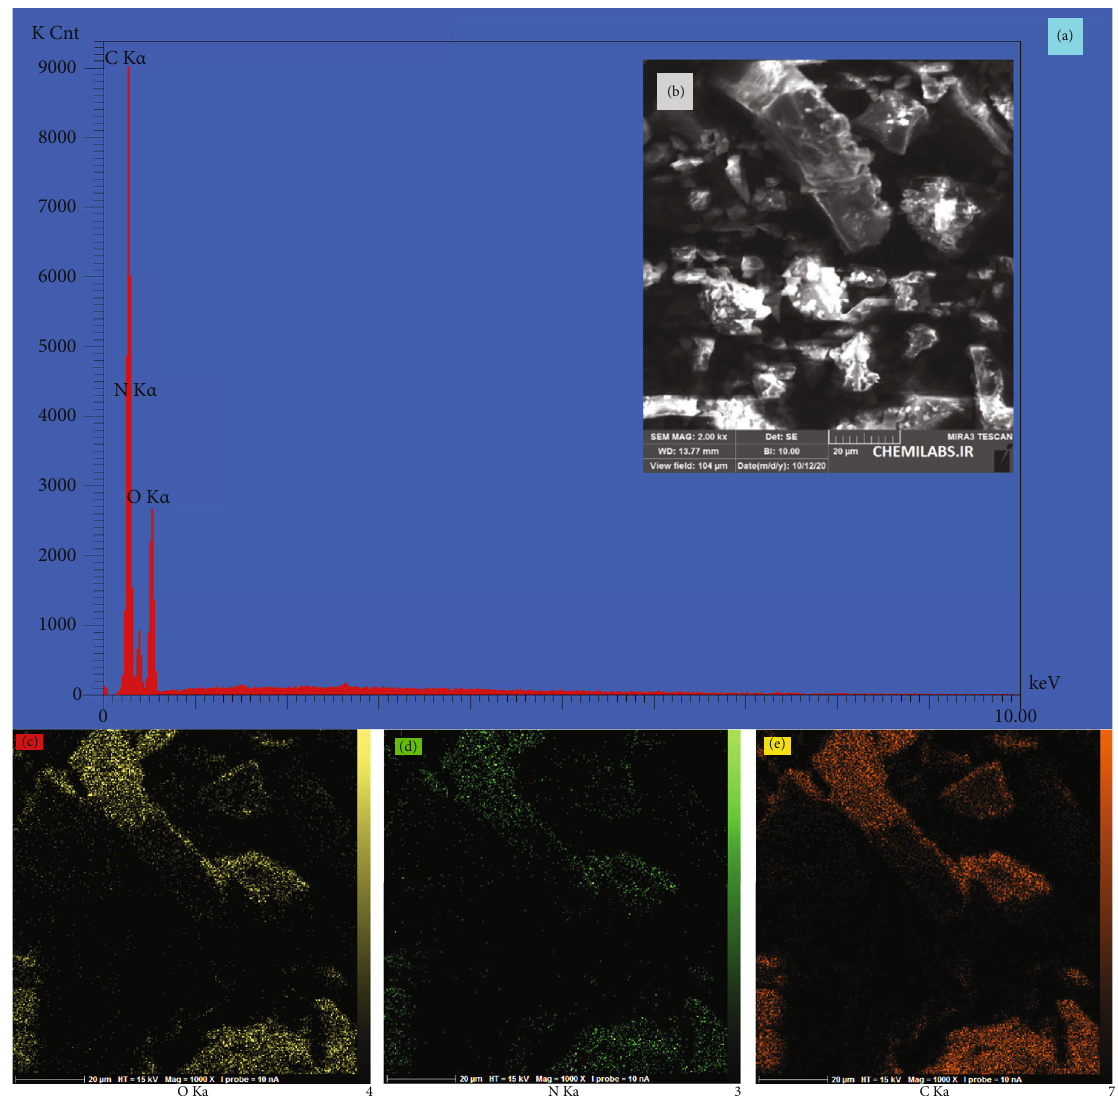
Figure 6: EDX-mapping pictures of NGQD nanoparticle. (a) EDX di ff raction pattern of nanoparticle, (b) SEM image of nanoparticle 2kx magni fi cation, (c) abundance image of C element, (d) abundance image of N element, and (e) abundance image of O